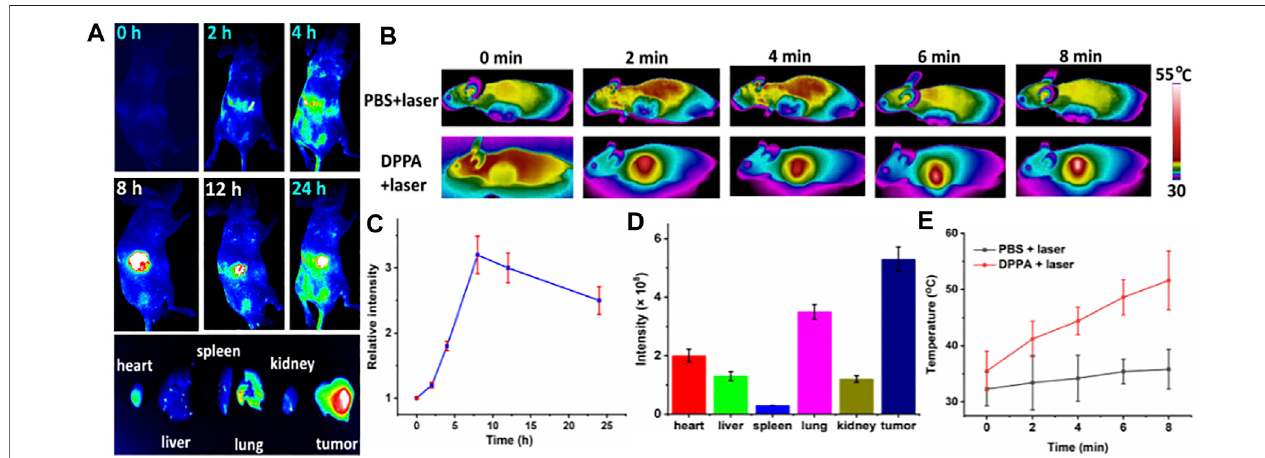
FIGURE 4 | (A) Time-dependent fl uorescence imaging of A498 tumor with intraveneous injection of DPPA NPs. (B) Photothermal imaging of the mouse with an injection of PBS and DPPA NPs (660 nm, 500 W/cm 2 , 8 min). (C) Quanti fi cation of the tumor intensity at different time points. (D) Quanti fi cation of the main organs and tumor. (E) Tumor temperature change of the PBS + laser and DPPA + laser groups.